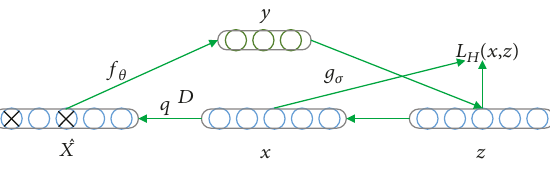
Figure 3: The concept of the denoising